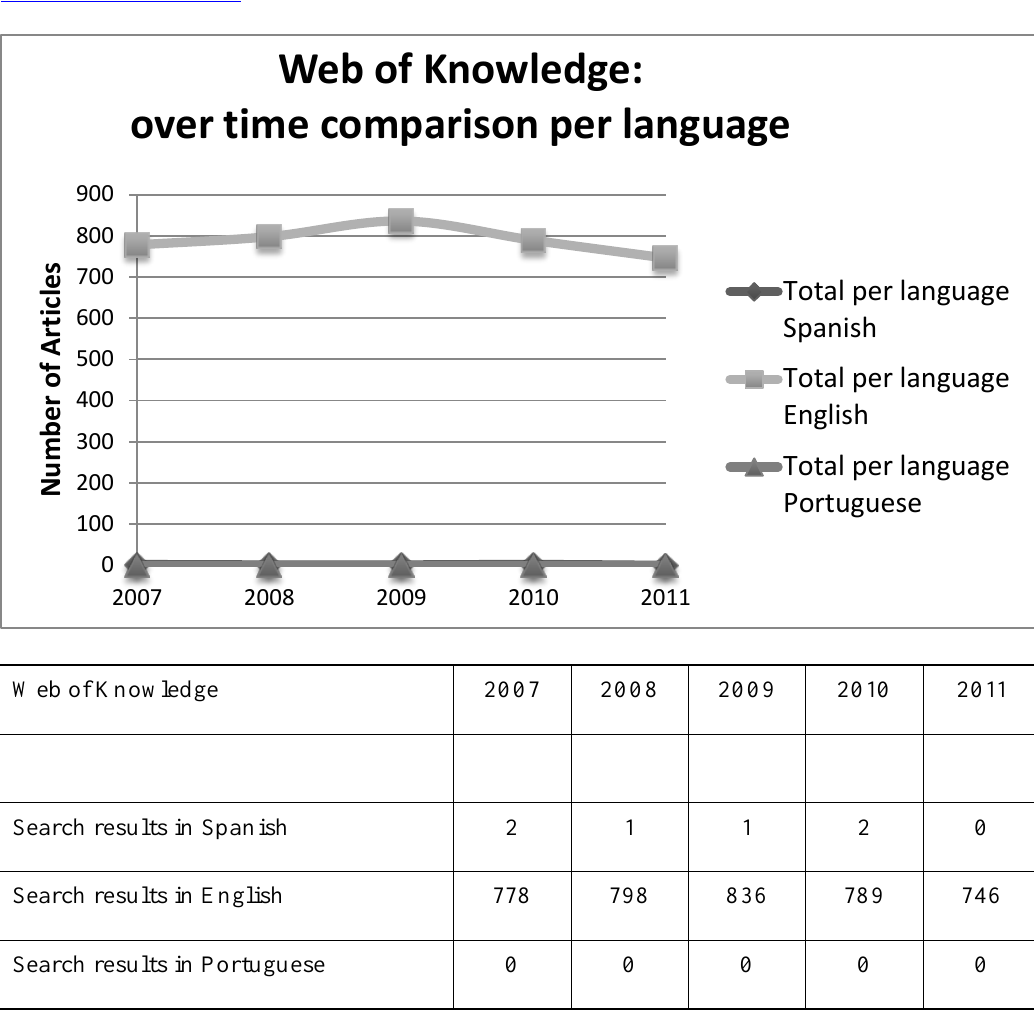
Figure 1 . Web of Knowledge: Over time comparison per language